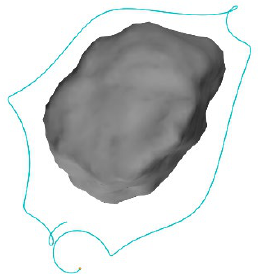
Figure 4. A complex orbit in the gravitational field of (6489) Golevka.